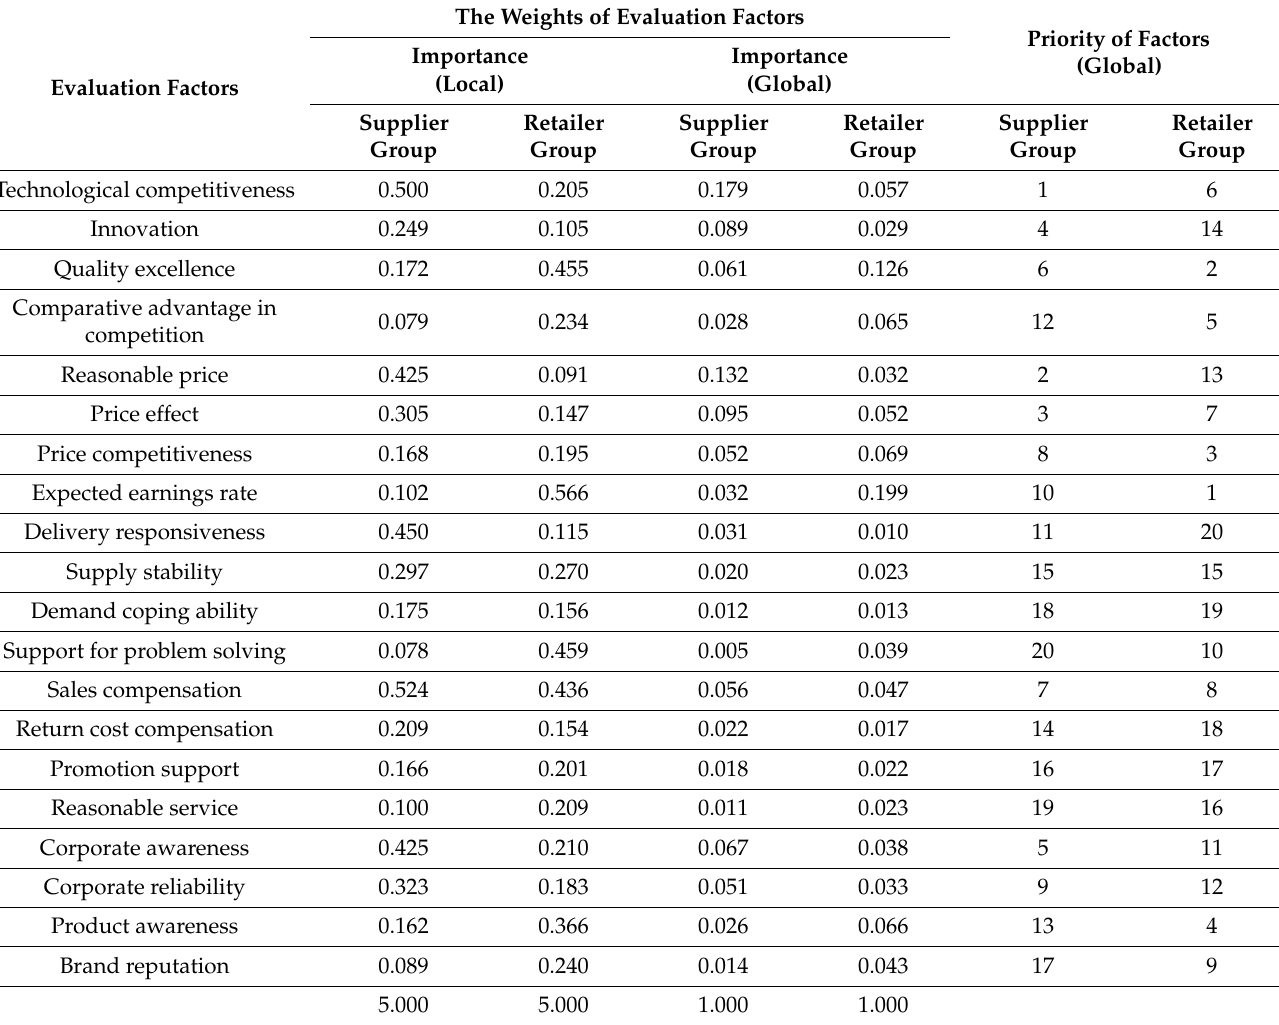
Table 6. Comparison analysis result on evaluation